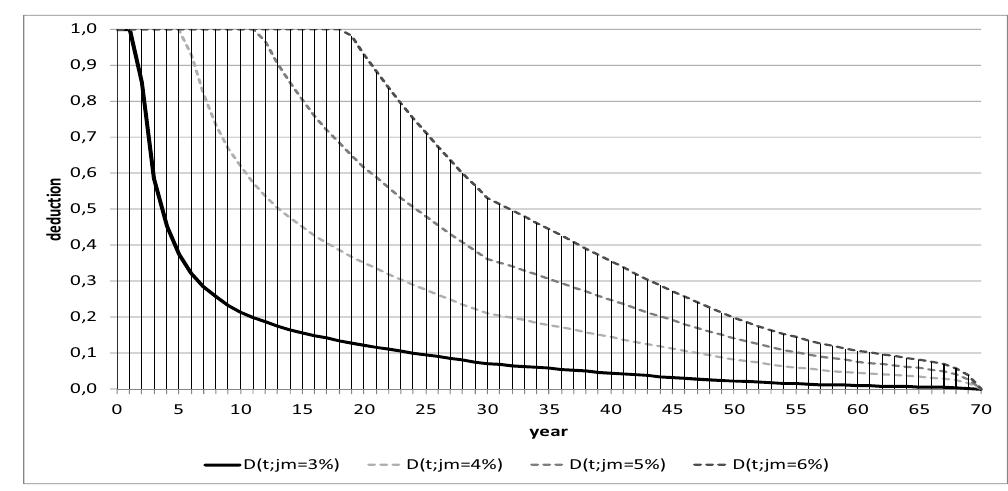
(cid:5) U for the evaluation rate j different values t